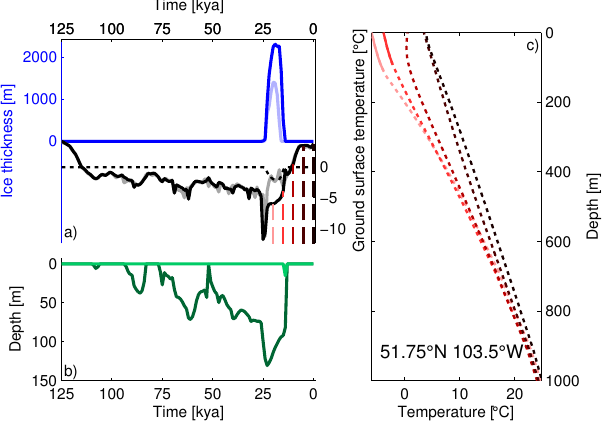
Figure 15. Same as Fig. 14 but for the southern flank of the Lau- rentide ice